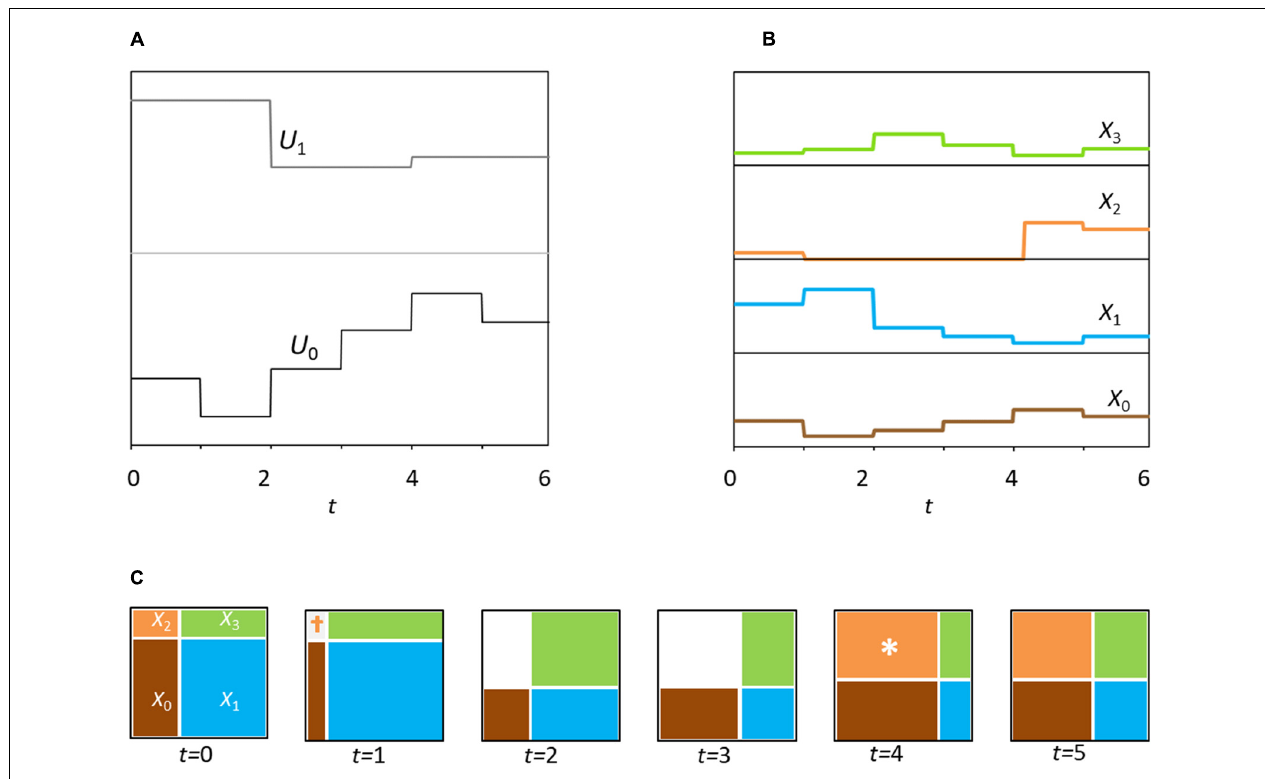
FIGURE 2 | (A) Dynamics of the environmental variation in time for six steps (position of partitions, as in Figure 1A ). Note that the partition for axis k assumes a new state at random every 2 k units of time, in this case one and two time steps, respectively. (B) Six time-steps of model dynamics for the four species. (C) Six panels showing the changes in niche-size ( V s ) for consecutive time steps. Colors denote occupation by the corresponding population ( X s ). Note the extinction of X 2 (species 2) at time t = 1 due to population falling below viability (‘ † ’), followed by two steps at zero and then at time t = 4, recolonization (‘ ∗